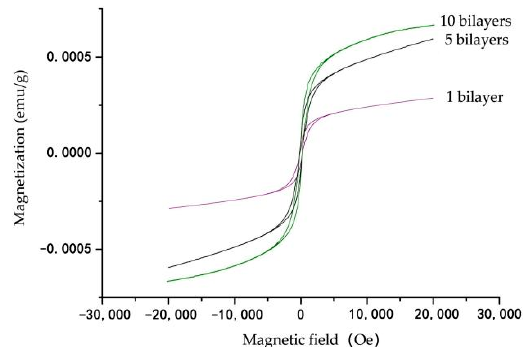
Figure 6. Vibrating sample magnetometer (VSM) curves of the magnetic wood with the number of alternating sedimentary layers at room temperature of 1 (purple), 5 (black), and 10 bilayers (green).